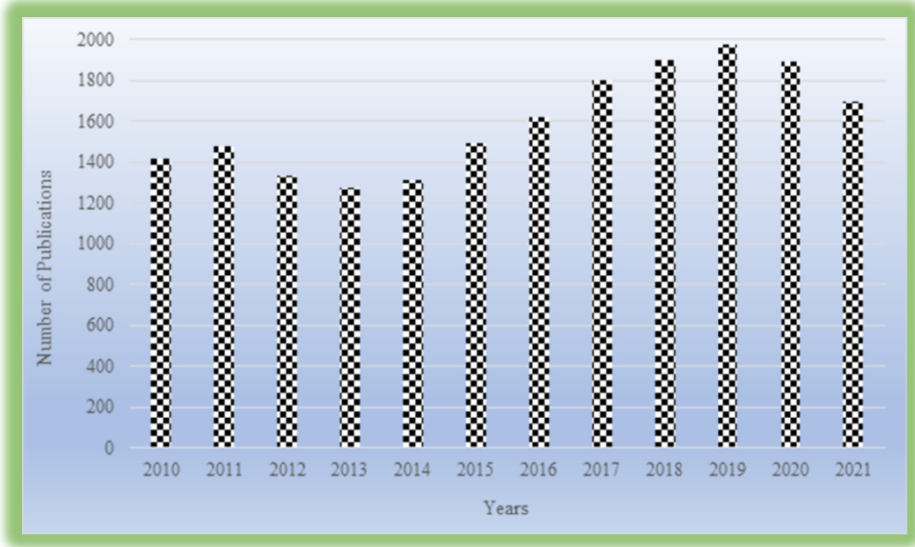
Figure Figure 1. Number of publications published on nanofluids per year (1 January 2010–31 December 2021, search word nanofluid on Scopus.com).